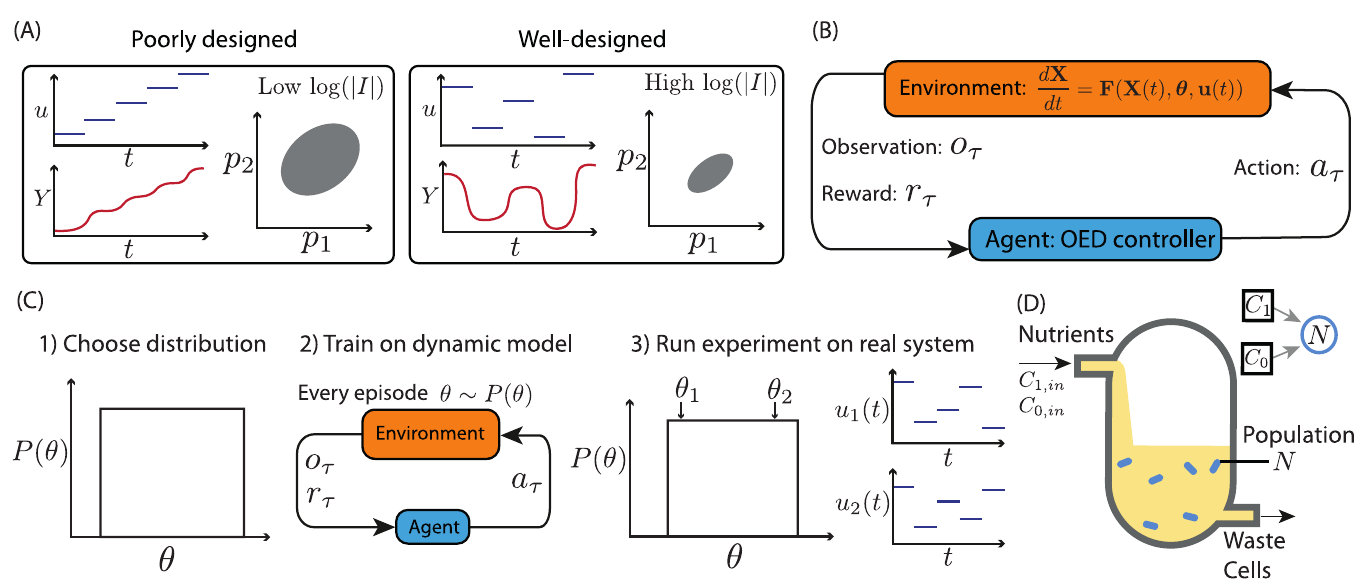
Fig 1. Reinforcement learning for optimal experimental design. A) A hypothetical example of a poorly designed experiment (left) corresponding to an increasing sequence of input values u over time, with a resulting continual increase in the observable output Y . A corresponding confidence ellipse in p 1 - p 2 parameter space is depicted. The logarithm of the determinant of the Fisher information matrix, log(| I |), is low. In contrast, a hypothetical well-designed experiment (right), which maximises the determinant of the Fisher information matrix, corresponds to non-intuitive choices of input, and a resulting dynamic response in the output. The corresponding confidence ellipse is tight and the determinant of the Fisher information is high. B) Optimal experimental design formulated as a reinforcement learning problem. The model dynamics, F , describe the rate of change of the state vector X in terms of model parameters θ and input u . For each time step, τ , an observation of the system, o , is provided to the agent which chooses an action, a , to apply over that time step and receives a corresponding reward, r . C) Training over a parameter τ τ τ distribution. 1) A distribution of parameters is chosen (shown as uniform). 2) The RL controller is trained. Each episode employs a model parametrisation θ sampled from the distribution. 3) When acting as a feedback controller, the trained RL agent designs near optimal experiments across the parameter distribution. For example well-designed experiments will be executed for either θ 1 and θ 2 (inputs u 1 ( t ) and u 2 ( t ) respectively). D) Model of an auxotrophic bacterial strain growing in a chemostat. The nutrient inflows, C and C 0, , can be controlled as part of an in in